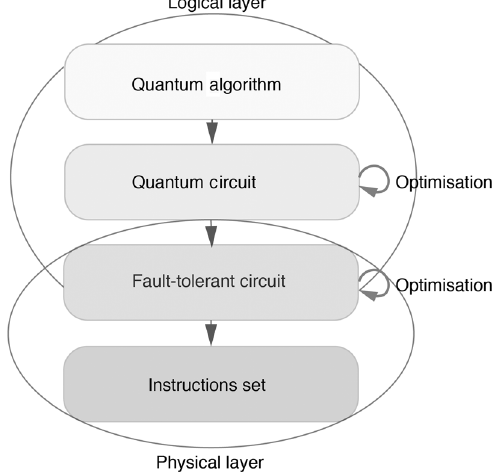
FIG. 1. General compilation stack of a large-scale quantum computer